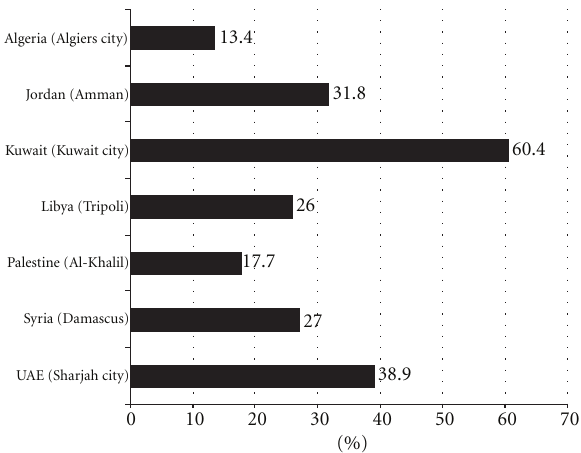
Figure 1: Comparison in prevalence of overweight and obesity among male adolescents (15–18 years) in seven Arab cities.